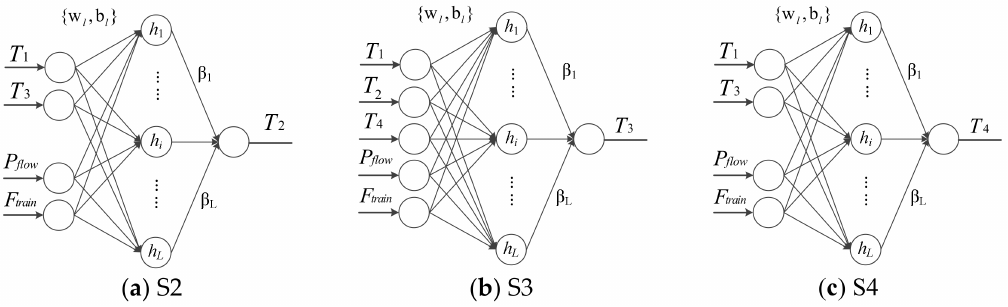
Figure 6. Final structures of traditional